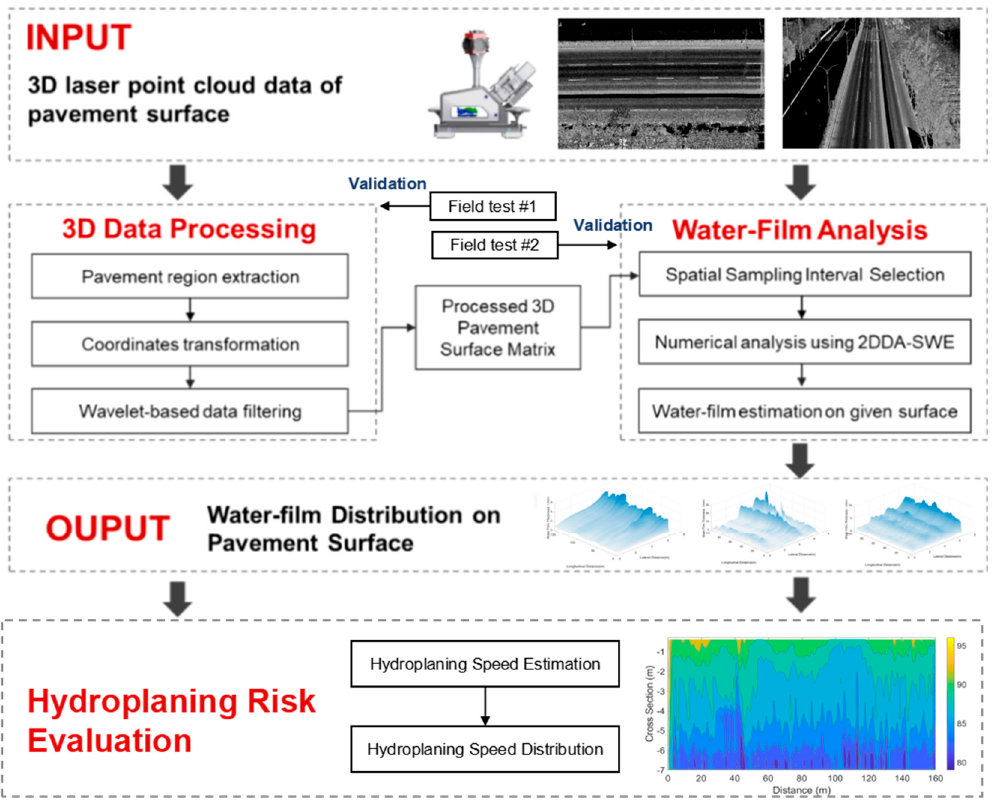
Figure 1. Pipeline of the proposed method.